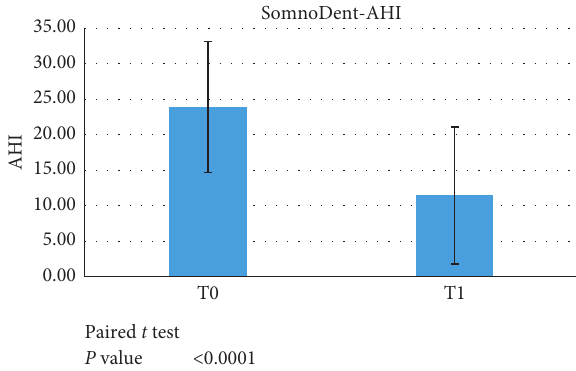
Figure 5: Paired t -test data showed significant differences between AHI at T0 versus T1 ( p < 0 . 05) when evaluating the use of the SomnoDent device.